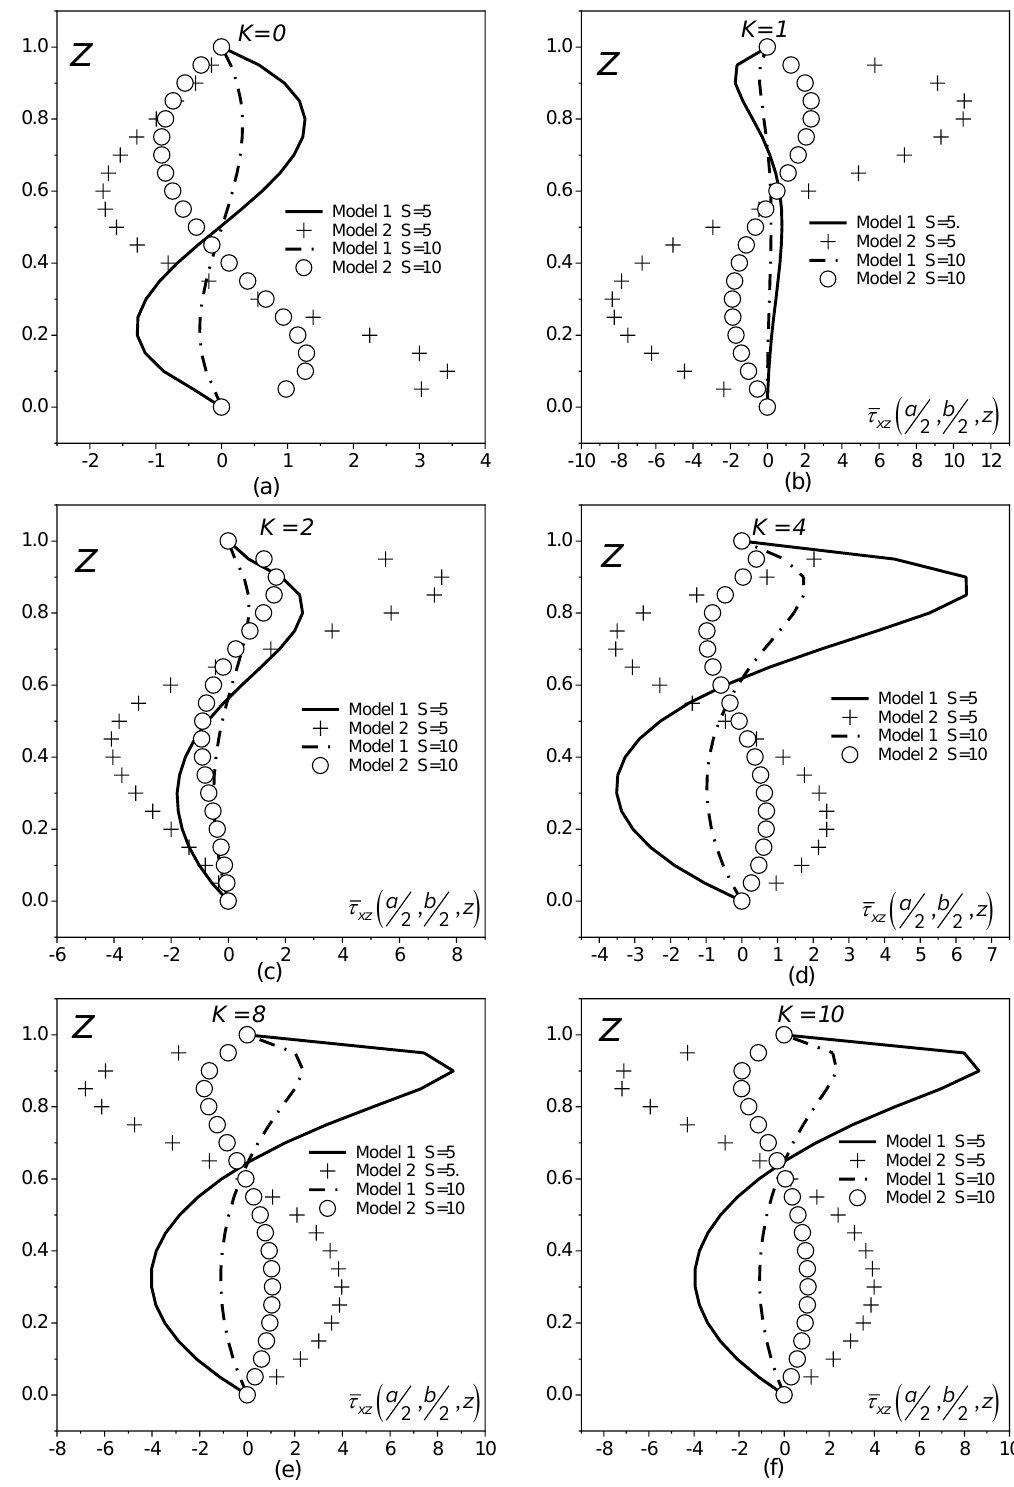
Fig. 10. Thickness variation of normalized Transverse displacement ( xz  ) for different material graded FG square laminate for material set